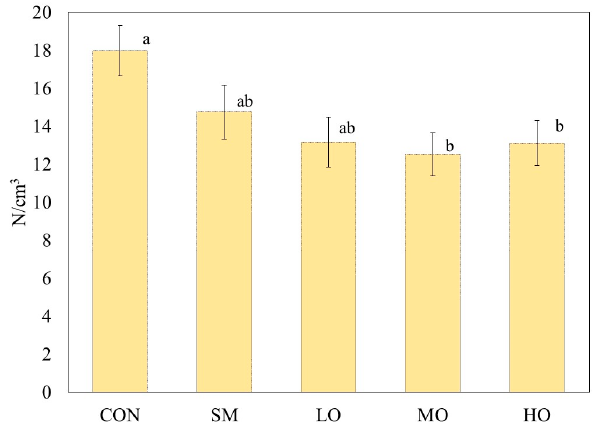
Figure 2. Means (± S.E.) of compression strength (N/cm 3 ) in m. Longissimus lumborum of male lambs unsupplemented (CON) or supplemented with monensin (SM), or three different levels of oregano essential oils (LO = 0.2 g/kg of DM; MO = 0.3 g/kg of DM or HO = 0.4 g/kg of DM). Compression strength analyses were performed after 7 d of simulated retail display in modified atmosphere packaging (O 2: CO 2 , 75:25%). a, b Different superscripts mean significant difference ( p ˂ 0.05) among treatments within variable.